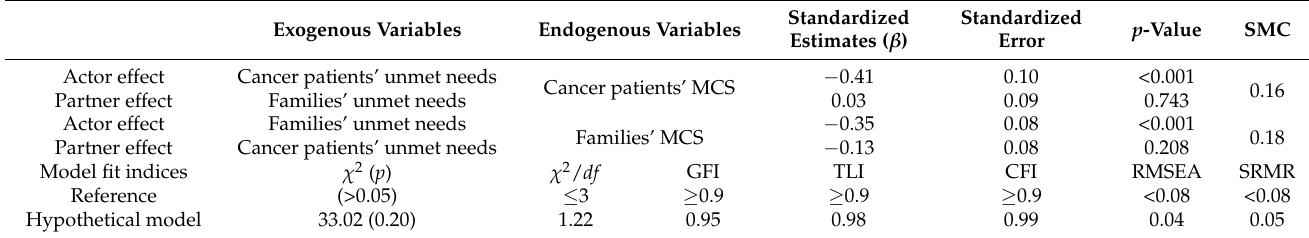
Table 7. Actor–partner effects and the model fit (MCS).